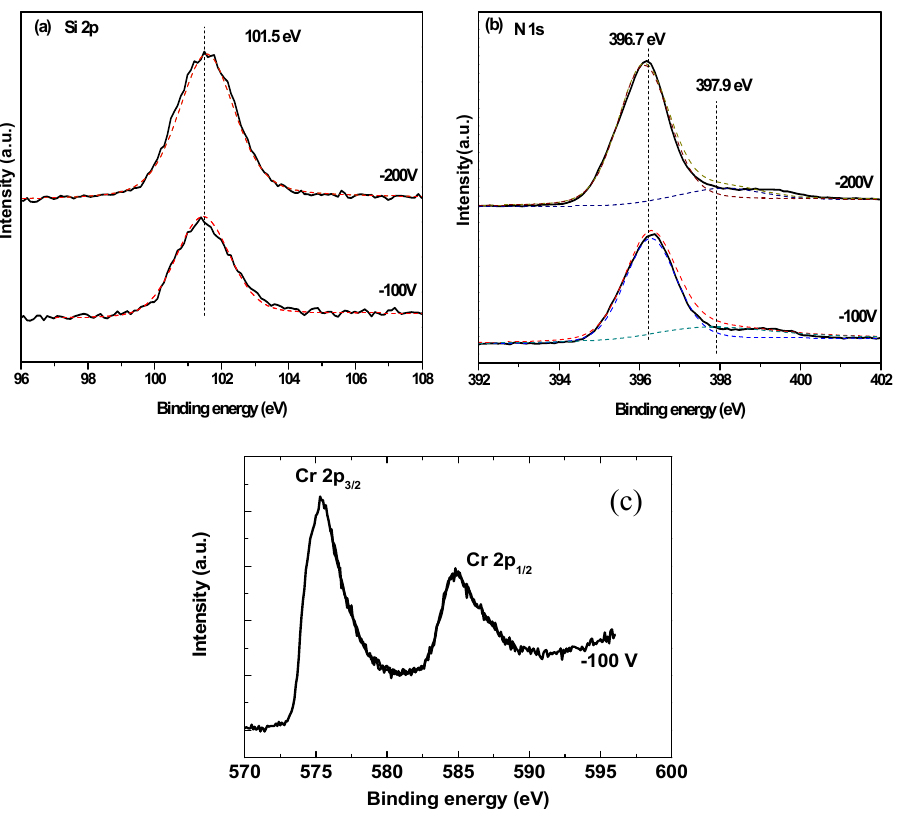
Figure 3. Si 2p ( a ), N 1s ( b ) and Cr 2p ( c ) spectra of Cr–Si–N coatings deposited under different bias voltages.